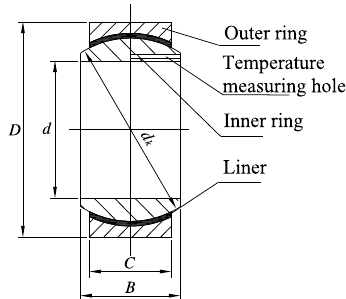
Fig. 1. Structurediagramofself-lubricatingsphericalplainbearing.